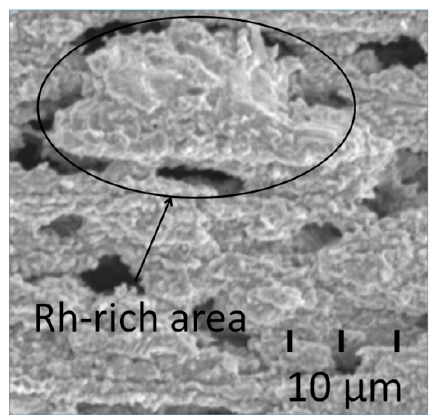
Figure 10. IrRh10 surface after oxidation, showing a loose oxidized particle.